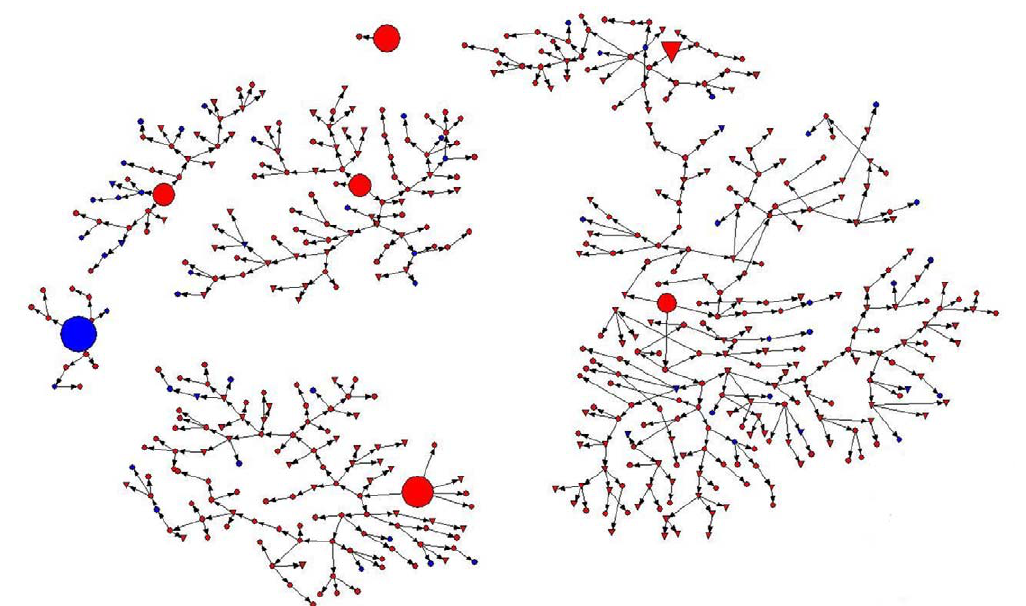
Figure 1. Diagram of respondent driven sampling procedures among MSM in Chongqing City, China: Circles represent non- students while triangles represent students; 7 larger circles or triangles represent the seeds; blue color for HIV-positive and red color for HIV-negative participants.